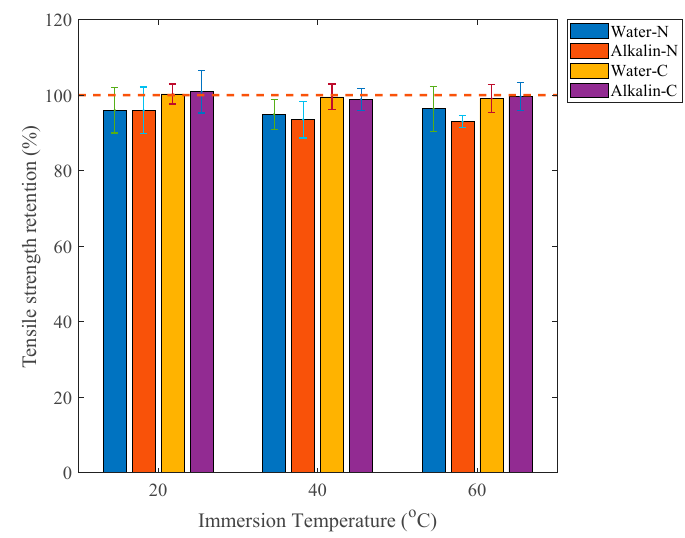
Figure 16. Tensile modulus retention of specimens immersed for three months.